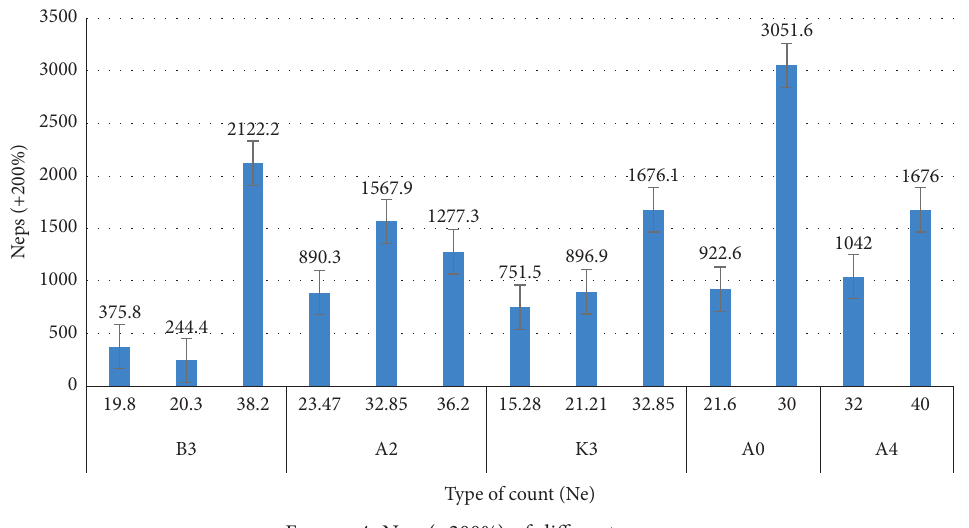
Figure 4: Nep (+200%) of different yarns. Table 5: Analysis of variance results of yarn evenness and imperfection (20Ne nominal count).